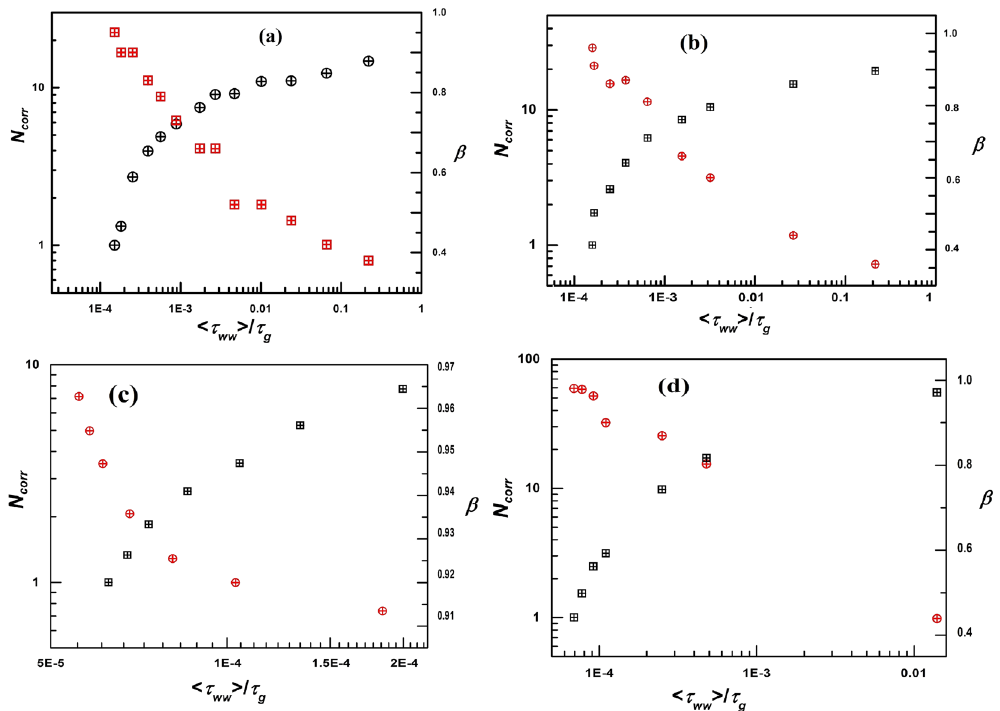
Figure 5. ( a ) Plot of N corr (black symbols) and β (red symbols) vs . < τ ww > / τ g for C L = 3.0 wt.%, ( b ) for C L = 3.25 wt.%. ( c ) with increasing φ at t w = 0 h and ( d ) with increasing φ at t w = 3 h. N corr shows a monotonic increase, With the initial rapid increase slowing down considerably at high < τ ww > / τ g while β shows a monotonic